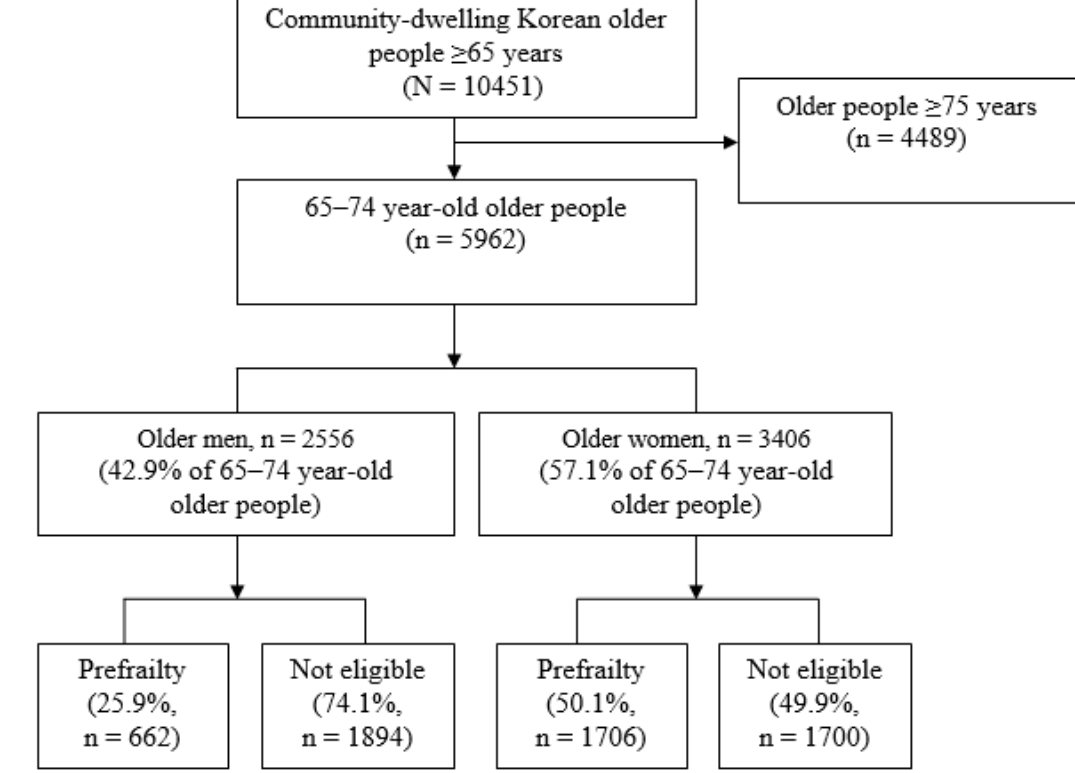
Figure 1. Flow diagram.